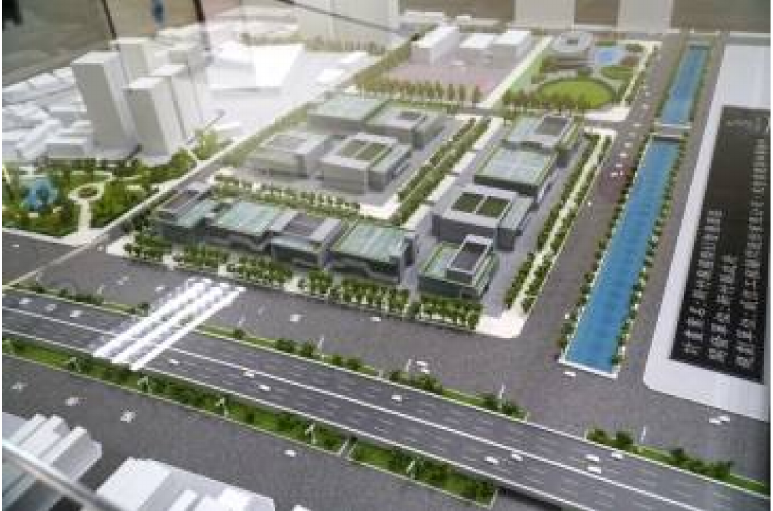
Figure 11. Hsinchu International AI Smart Park.